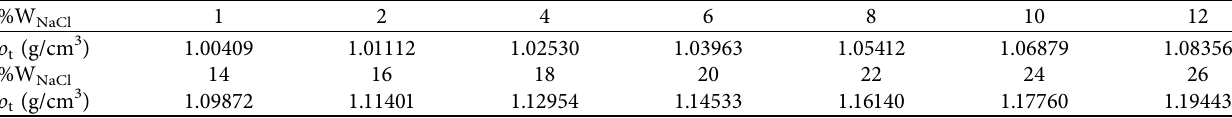
Table 1: Experimental data between %W the least squares method.